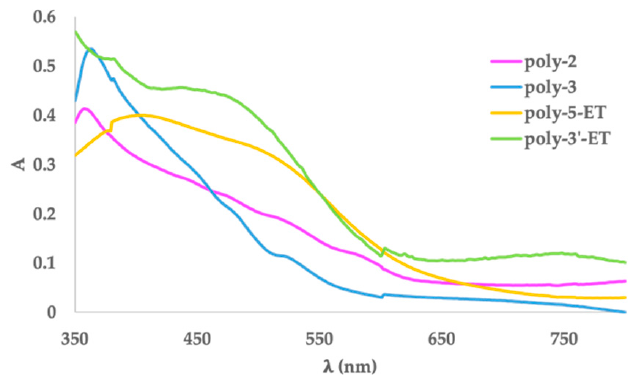
10 of 14 Table 4. Voltammetric data in CH 3 CN/TEAPF 6 0.1 M and UV-Vis data of the polymer films. E ox (V)